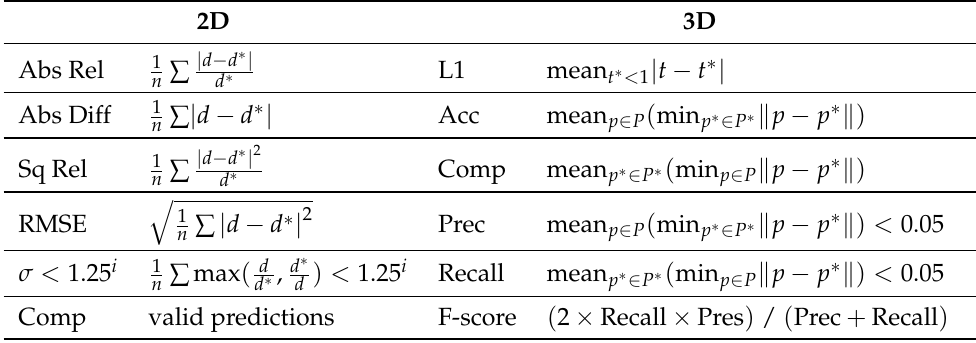
Table 2. The evaluation metrics of 2D depth estimation and 3D reconstruction used in our experiment.